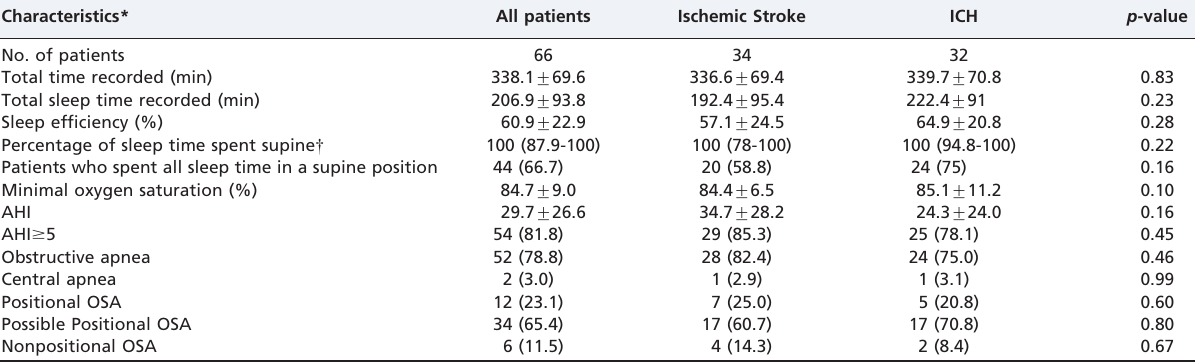
Table 2 - Polysomnographic findings. Characteristics* All patients